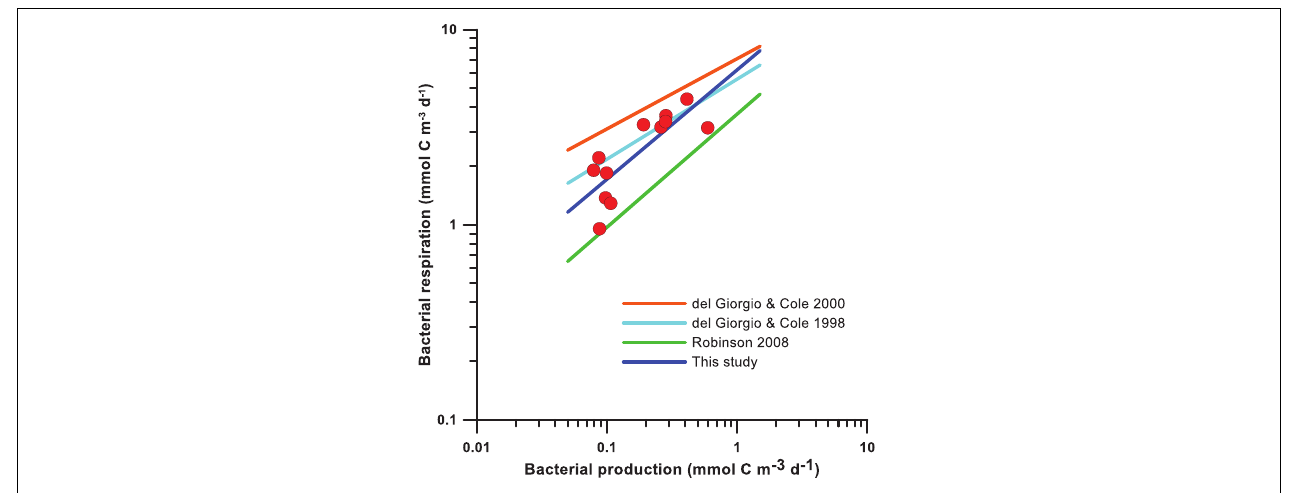
FIGURE A2 | Estimation of bacterial respiration from bacterial production using various models. Red dots denote the direct measurements of bacterial production and respiration.